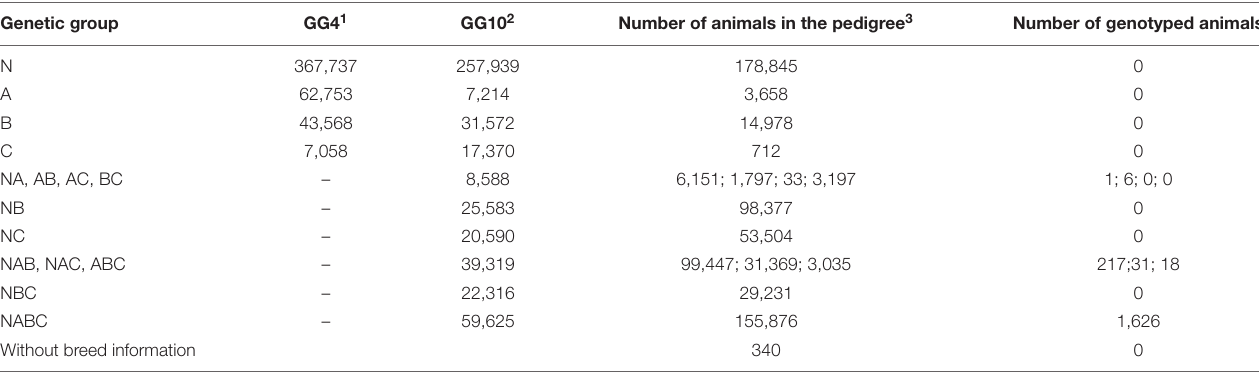
TABLE 1 | Numbers of missing parents, pedigree animals, and genotyped animals per genetic group. Genetic group GG4 1 GG10 2 Number of animals in the pedigree 3 Number of genotyped